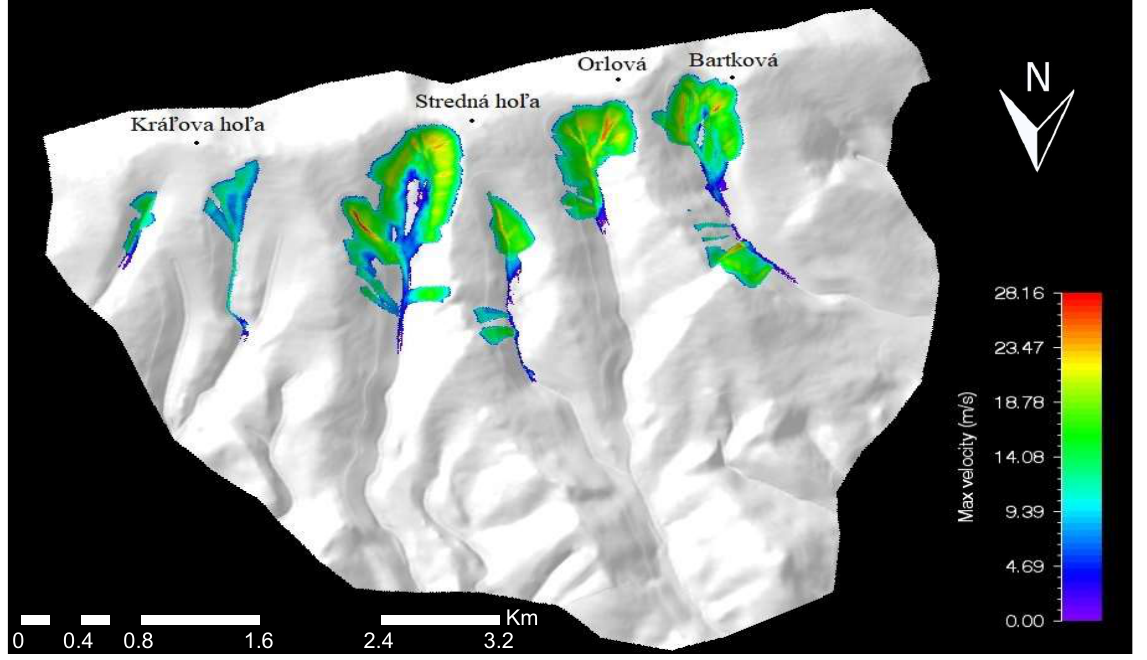
Figure 8. Maximum avalanche flow speed (northern slope).